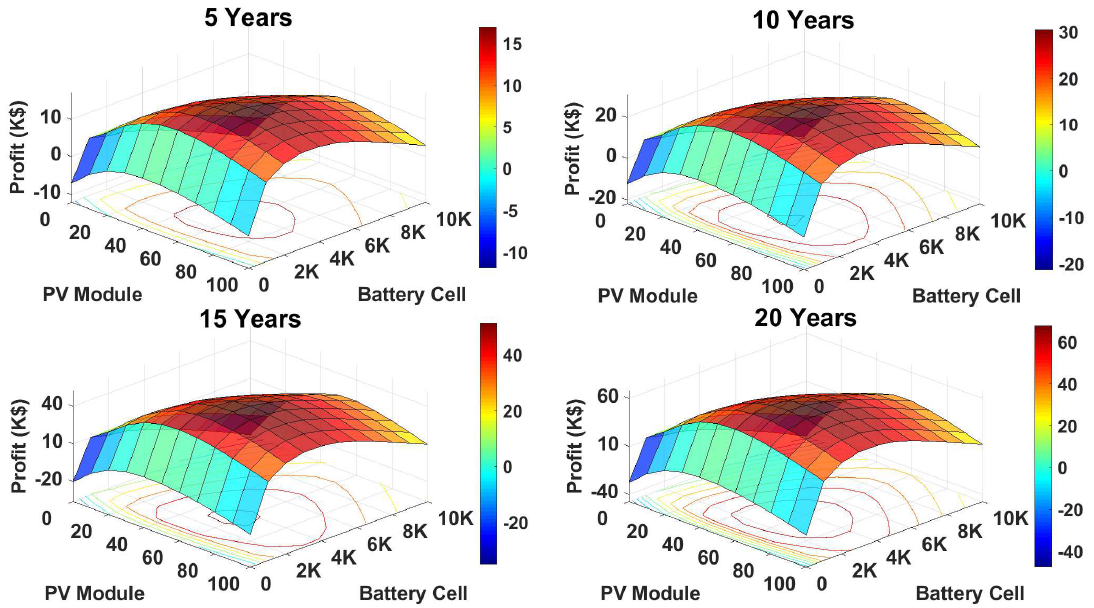
Figure 12. Profit in different years with various configurations for case with wind turbine in